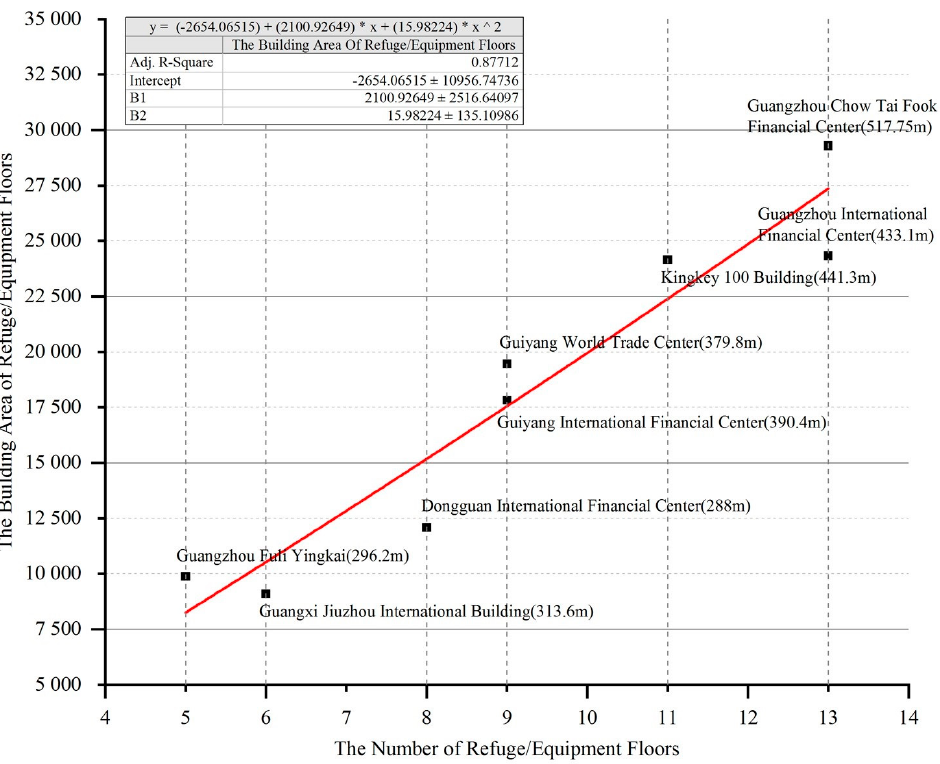
Figure 26. Building utilization rate k 3 .